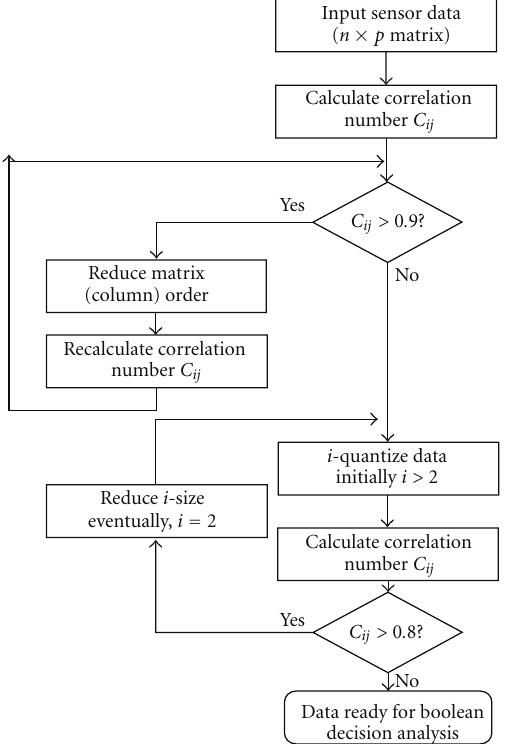
Figure 2: Boolean reduction